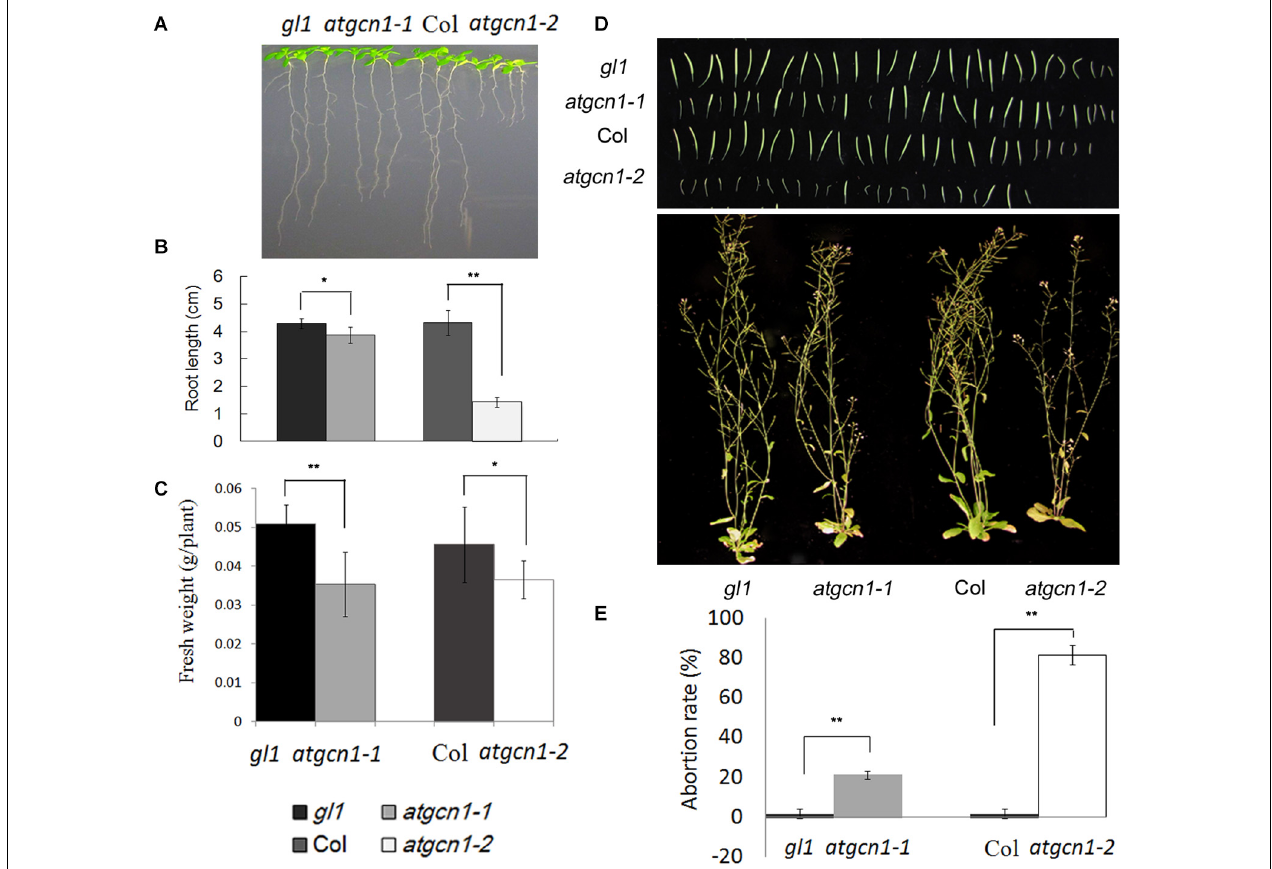
FIGURE 2 | AtGCN1 is required for plant growth and seed development. (A) The root length of atgcn1-1 and atgcn1-2 is shorter than that of WT. (B) The measurement of root length. (C) The fresh weight of atgcn1-1 and atgcn1-2 is less than that of WT. (D) Seed development is impaired by atgcn1 mutations. (E) The statistical analysis of abortive siliques. Statistical t -tests were performed. Single asterisk indicates significant difference with a p -Value < 0.05. Double asterisks indicate significant difference with a p -Value < 0.01. Experiments were repeated three times with similar results attained.